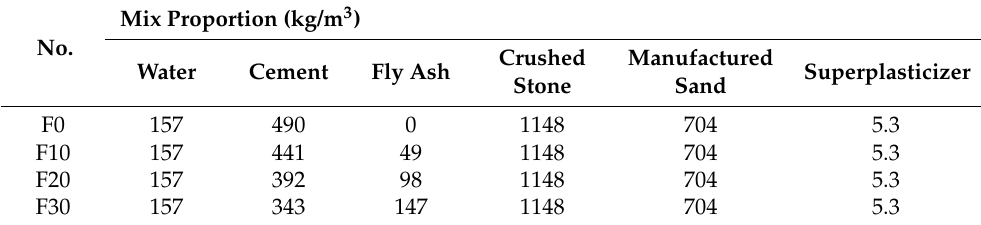
Table 2. Mix proportion of concrete with different FA contents.